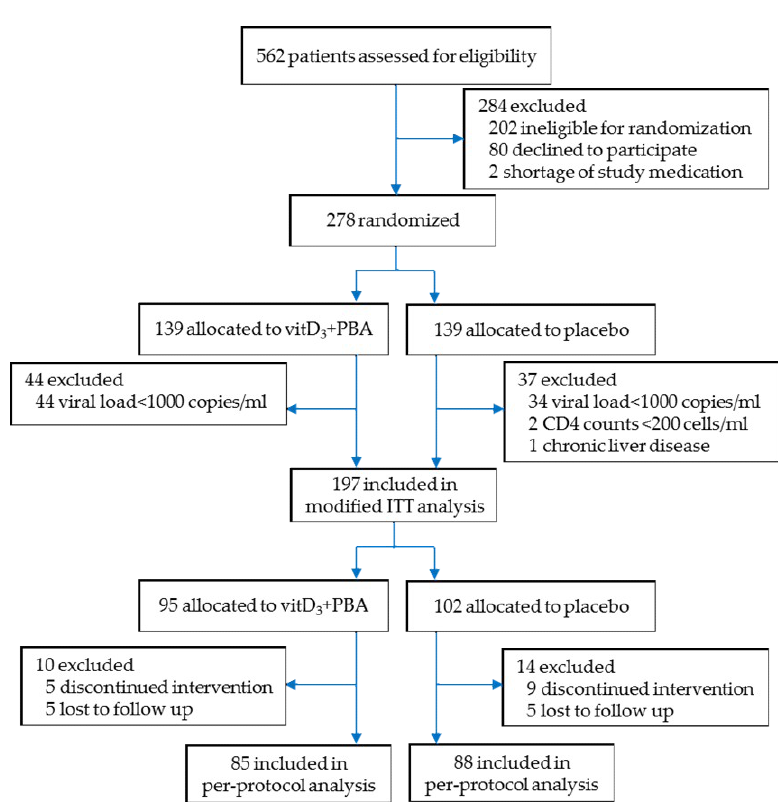
Figure 1. Trial profile. Flow diagram of patients screened for human immunodeficiency virus (HIV) infection. Patients ineligible for randomization included age <18 years ( n = 27), pregnancy or breast feeding ( n = 40), home parenteral nutrition ( n = 56), low HIV viral loads <1000 copies/mL ( n = 60), low CD4 + T cell counts <350 cells/ µ L ( n = 16), initiated antiretroviral therapy (ART; n = 1), liver diseases ( n = 2), shortage of study medication ( n = 2) and patients who declined to participate ( n = 80). Delayed laboratory results that were received after randomization confirmed that some patients had low HIV viral loads <1000 copies/mL ( n = 78), liver disease ( n = 1), and low CD4 + T cells counts <200 cells/ µ L ( n = 2). Discontinued intervention included patients who initiated ART ( n = 8), pregnancy ( n = 3), tuberculosis infection ( n = 2), and adverse events ( n = 1). Patients who dropped out from the study included patients who withdrew their consent (=6), moved from the study area ( n = 3), or could not be reached ( n =